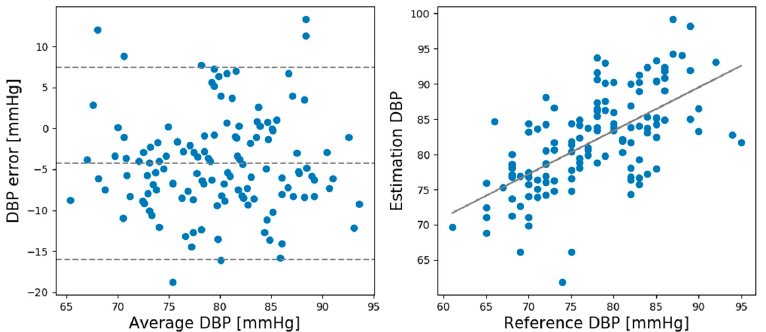
Figure 6. Bland–Altman plots for diastolic blood pressure (DBP) estimations made by the CNN Model in the rest session.